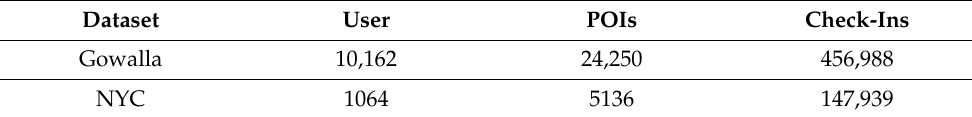
Table 2. Basic dataset statistics.